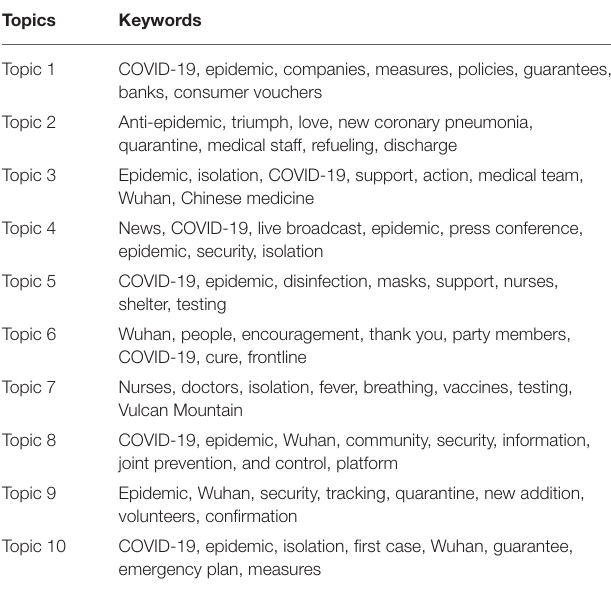
TABLE 4 | Subject classification of disclosure of experience